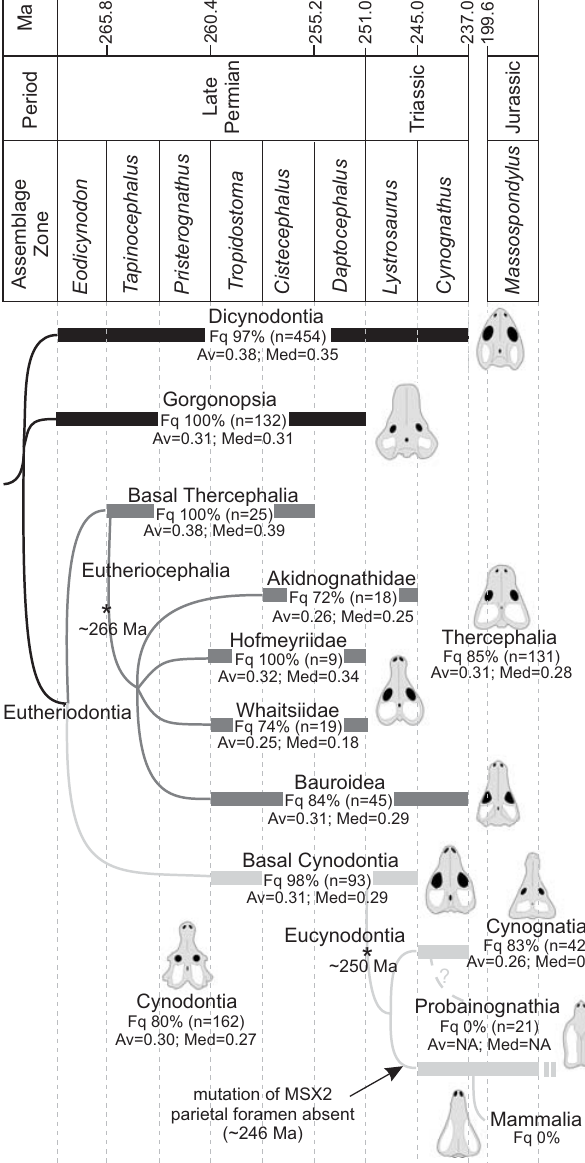
Fig. 2. Evolution of the frequency of the presence of the parietal foramen (Fq), and average (Av) and median (Med) size of the parietal foramen across the phylogeny of Therapsida. Number of specimens examined (n) is indicated for each group. Asterisks indicate the branches of the tree where a relaxation of constraints resulting from a functionless third eye is hypoth- esized (zone of variability). See material and methods section for the more details about the phylogenetic